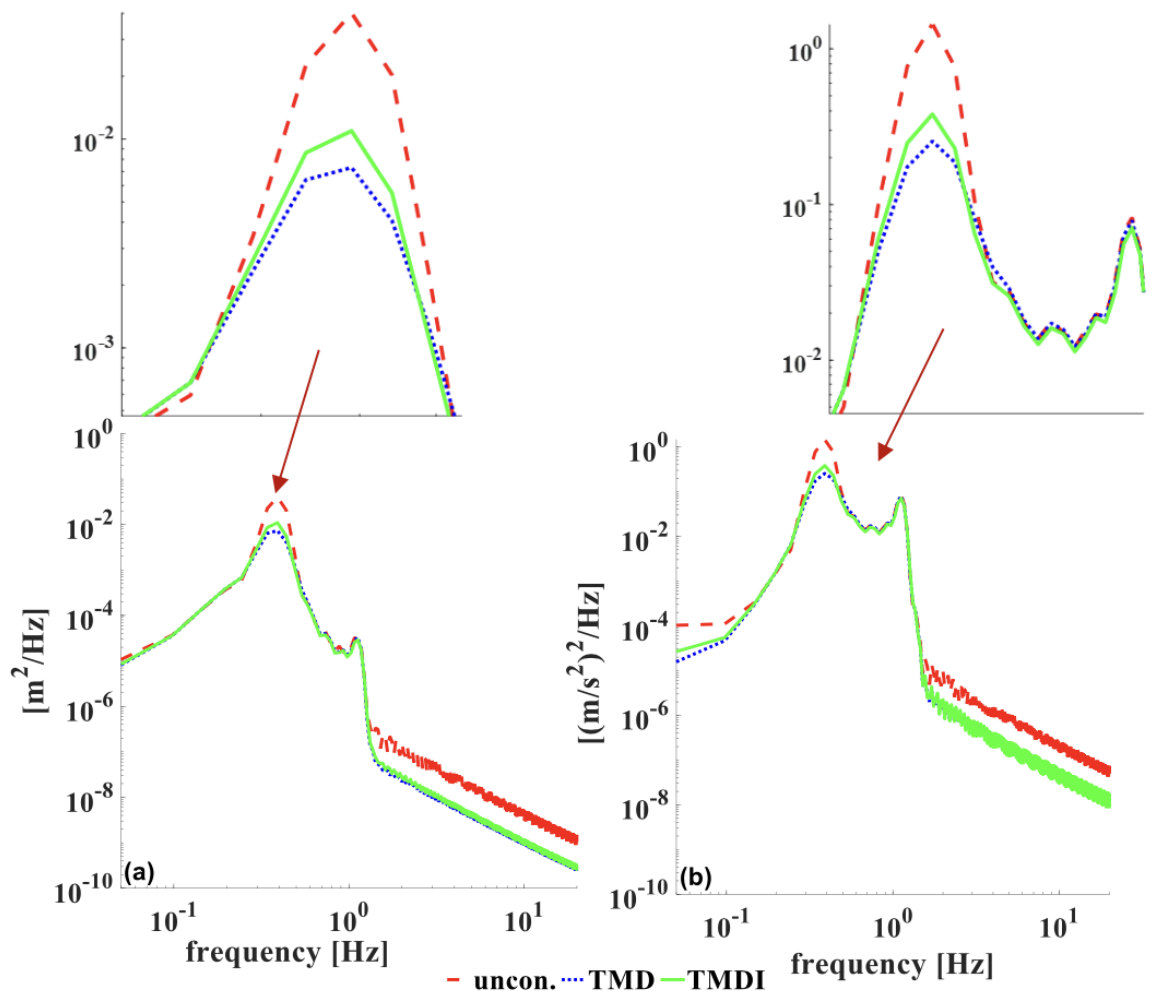
Figure 13. Responses of the 42nd story under variable frequency excitation: ( a ) displacement and ( b ) acceleration spectra.